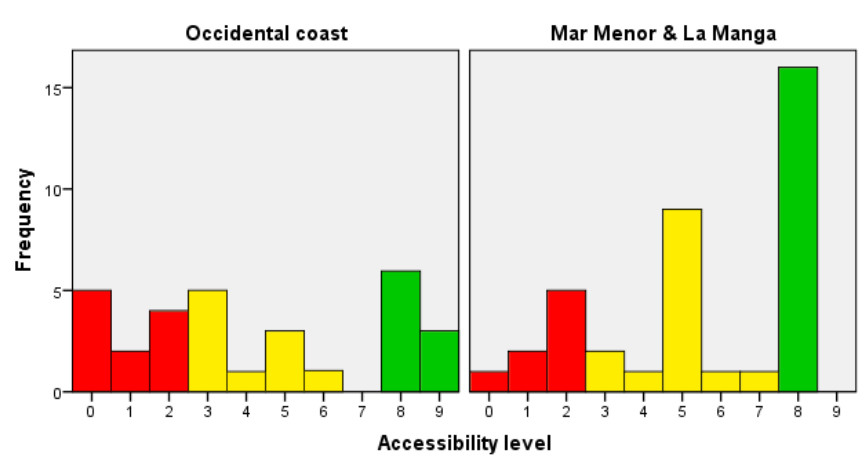
Figure 5. Histograms of accessibility divided by area to show differences between the beaches in the Occidental coast and Mar Menor & La Manga. Red: low; yellow: intermediate; and green: